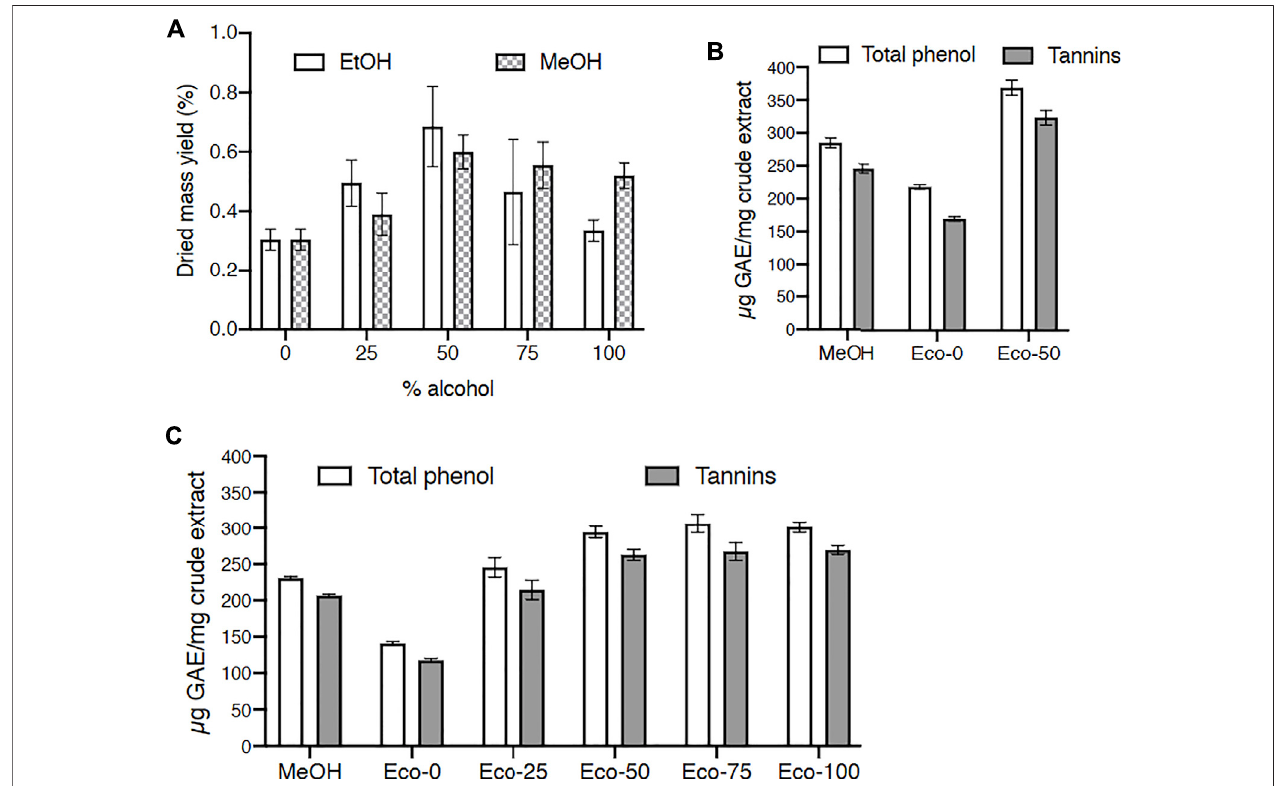
FIGURE 4 | Effect of solvents on dried mass, total phenol and tannin yields for Carapa procera DC. and Pericopsis laxifora (Benth. ex Baker) Meeuwen. (A) : Dried massyieldfor C.procera withhydro-alcoholicsolventscontaining0 – 100%alcohol. (B,C) :Totalphenolandtanninyieldsfor C.procera (B) and P.laxifora (C) ;GAE:gallic acid equivalent; Eco: hydroalcoholic eco-extracts with 0 – 100% ethanol; MeOH: crude methanolic extracts.